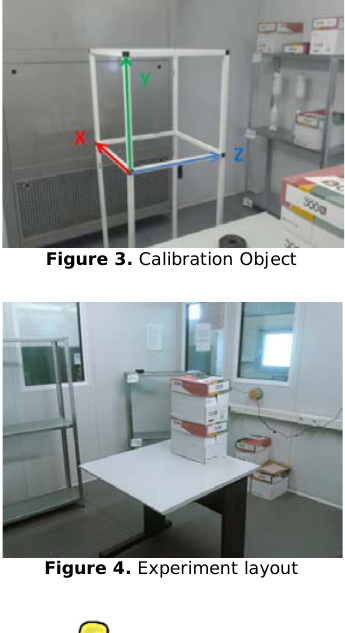
Figure 4. Experiment layout